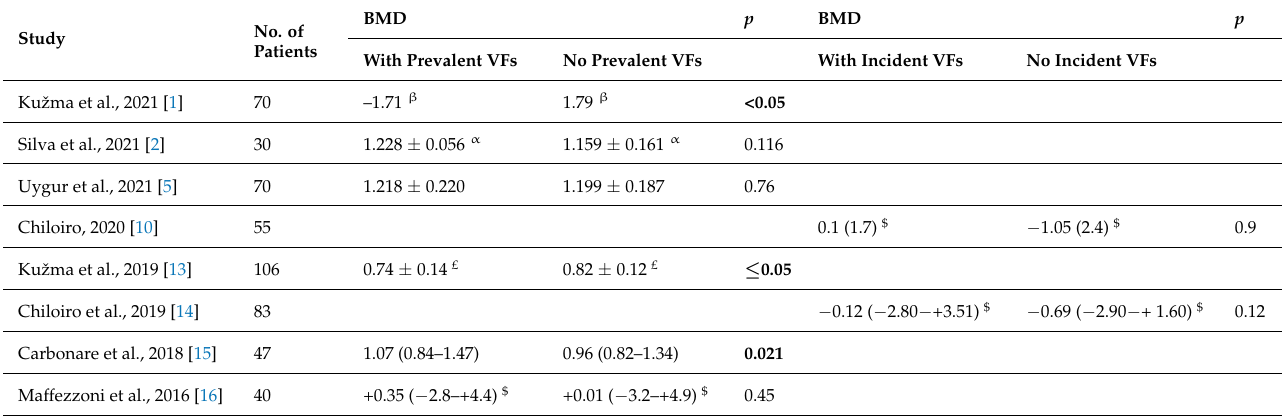
Table 4. Correlations reported between bone mineral density and vertebral fracture